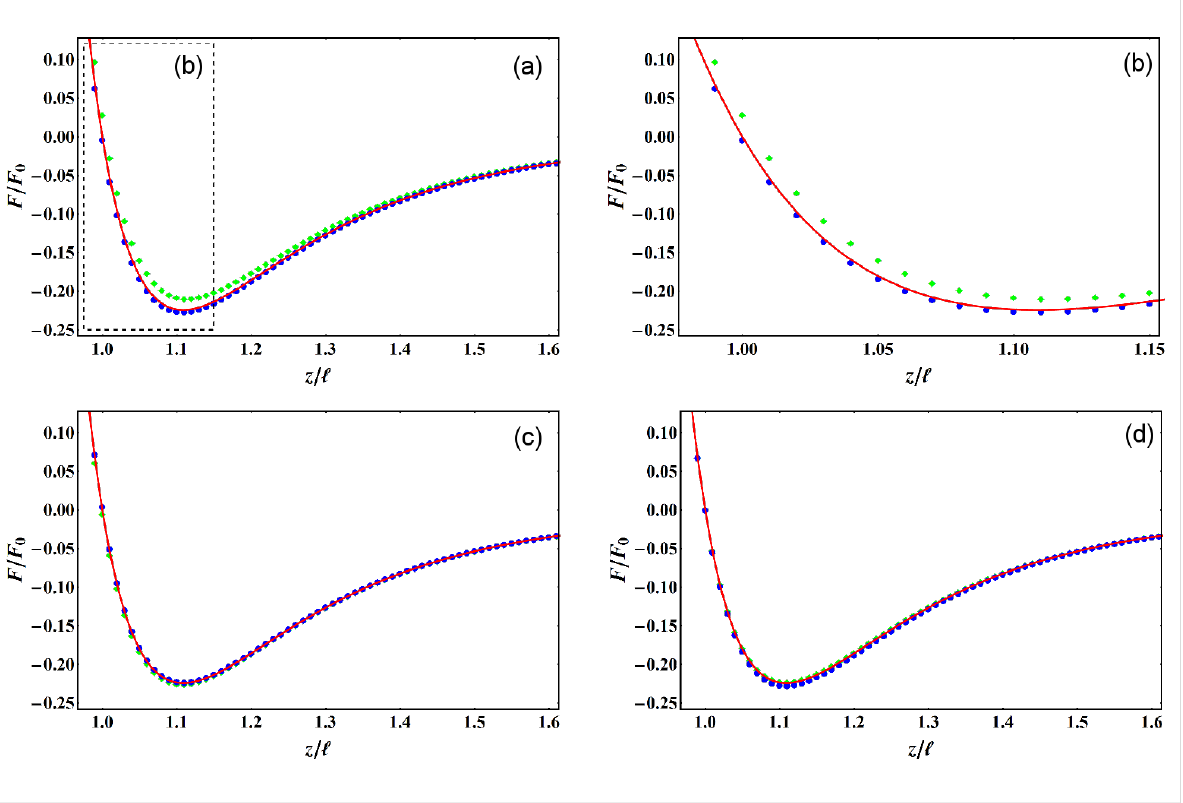
Figure 1: Lennard–Jones interaction (solid red line) and reconstructed forces. Blue circles depict reconstruction using the second harmonic. Green diamonds depict reconstruction using the Sader–Jarvis formula for the fundamental harmonic. Amplitudes of oscillation used are / ℓ = 0.1 (a), / ℓ = 1 (c), / ℓ = 10 (d). (b) depicts magnification of the dashed frame marked in